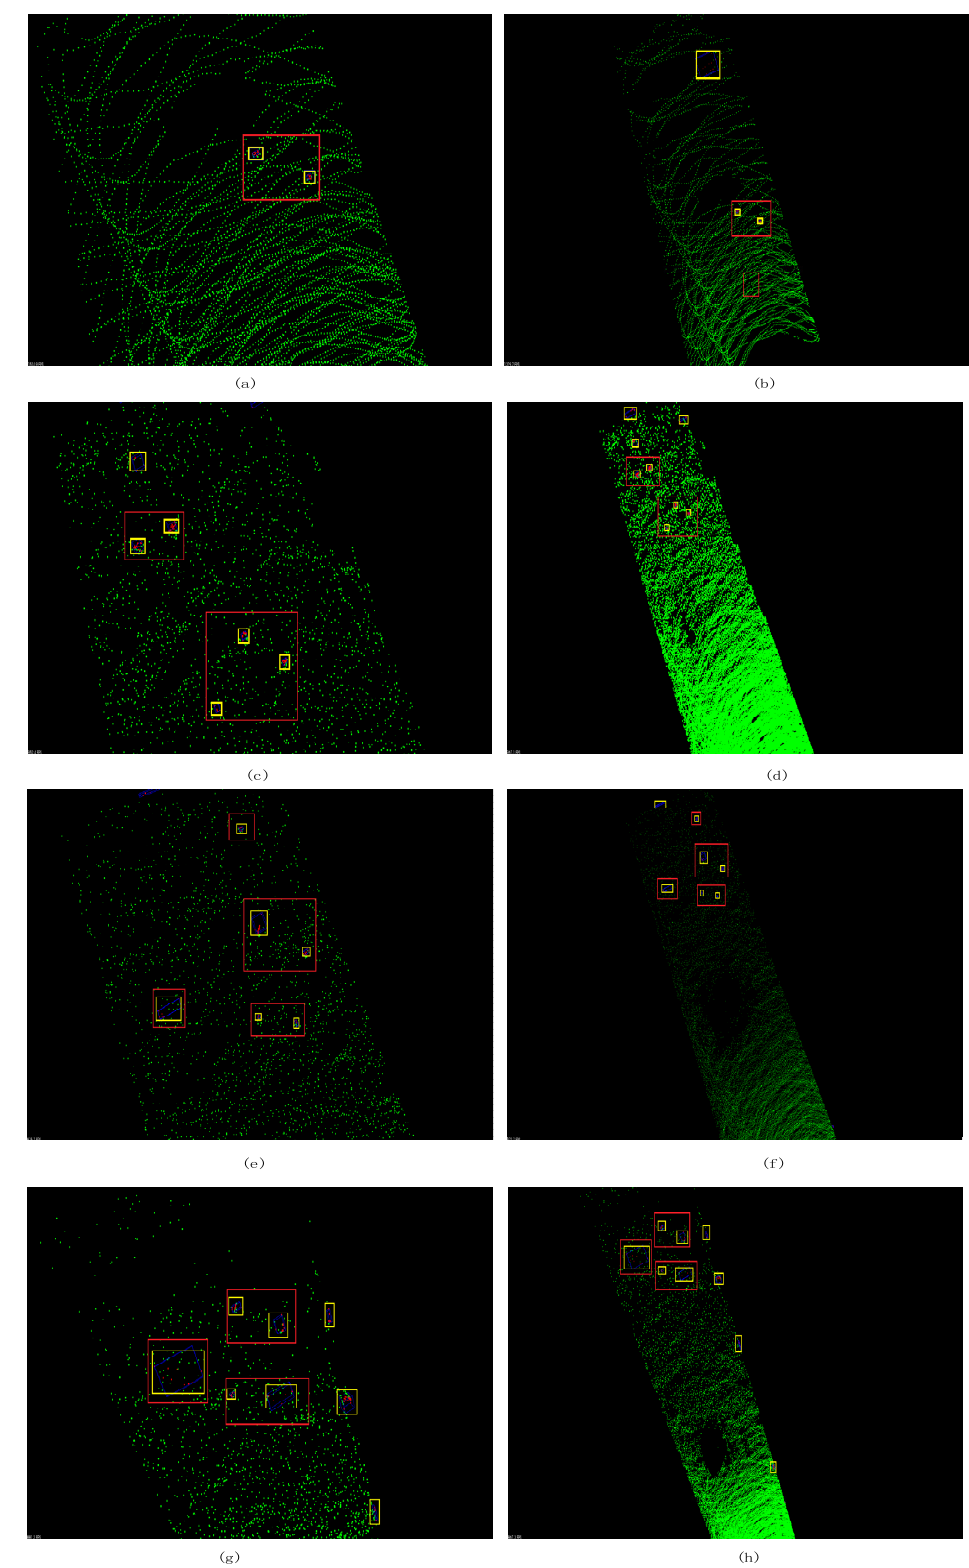
Figure 8 . The experimental results of the whole dataset, the left is a partial enlarged view, and the right is a global view. The red rectangle includes the right detected rocks, the detected obstacles outside the red rectangle are errors ( a , b ) show the results of dataset1, two of the three rock blocks were detected; ( c , d ) show the results of dataset2, and five of the six rock blocks were detected; ( e , f ) show the results of dataset3, all six rock blocks have been detected; ( g , h ) show the results of dataset4, five of the six rock blocks were detected.